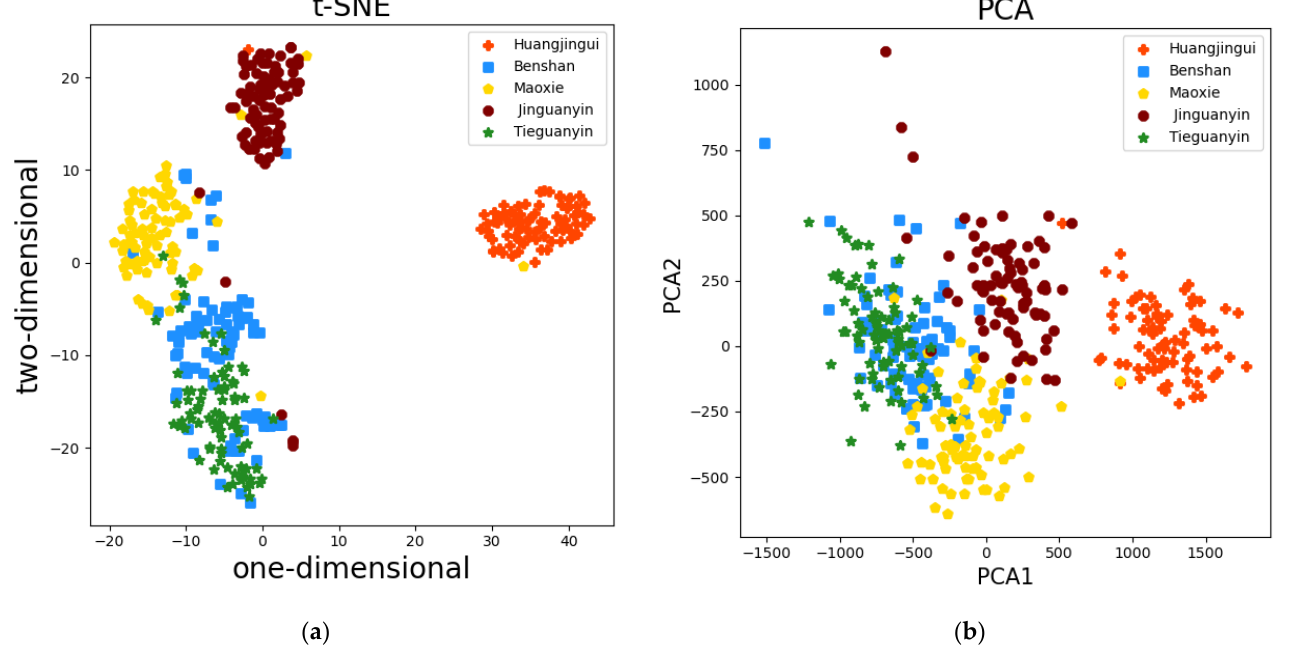
Figure 8. Diagrams reduced to two dimensions. ( a ) The visual display of t-SNE ( b ) The visual display of PCA.